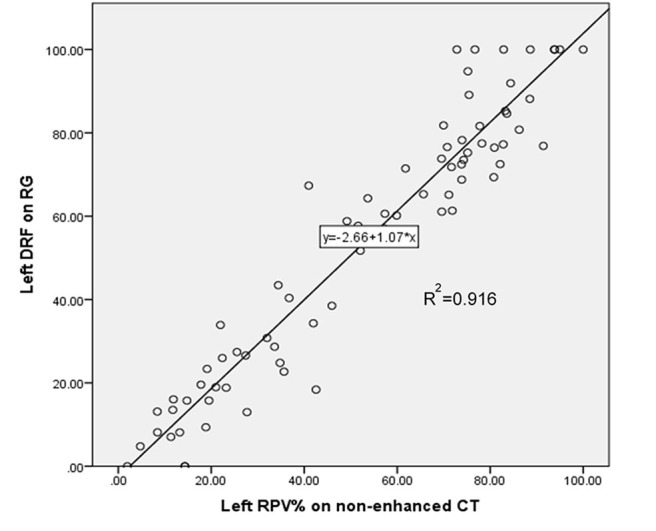
Linear regression of unenhanced computerized tomography (CT) percent left residual parenchymal volume (RPV) estimating left differential renal function (DRF) on nuclear renography (RG).